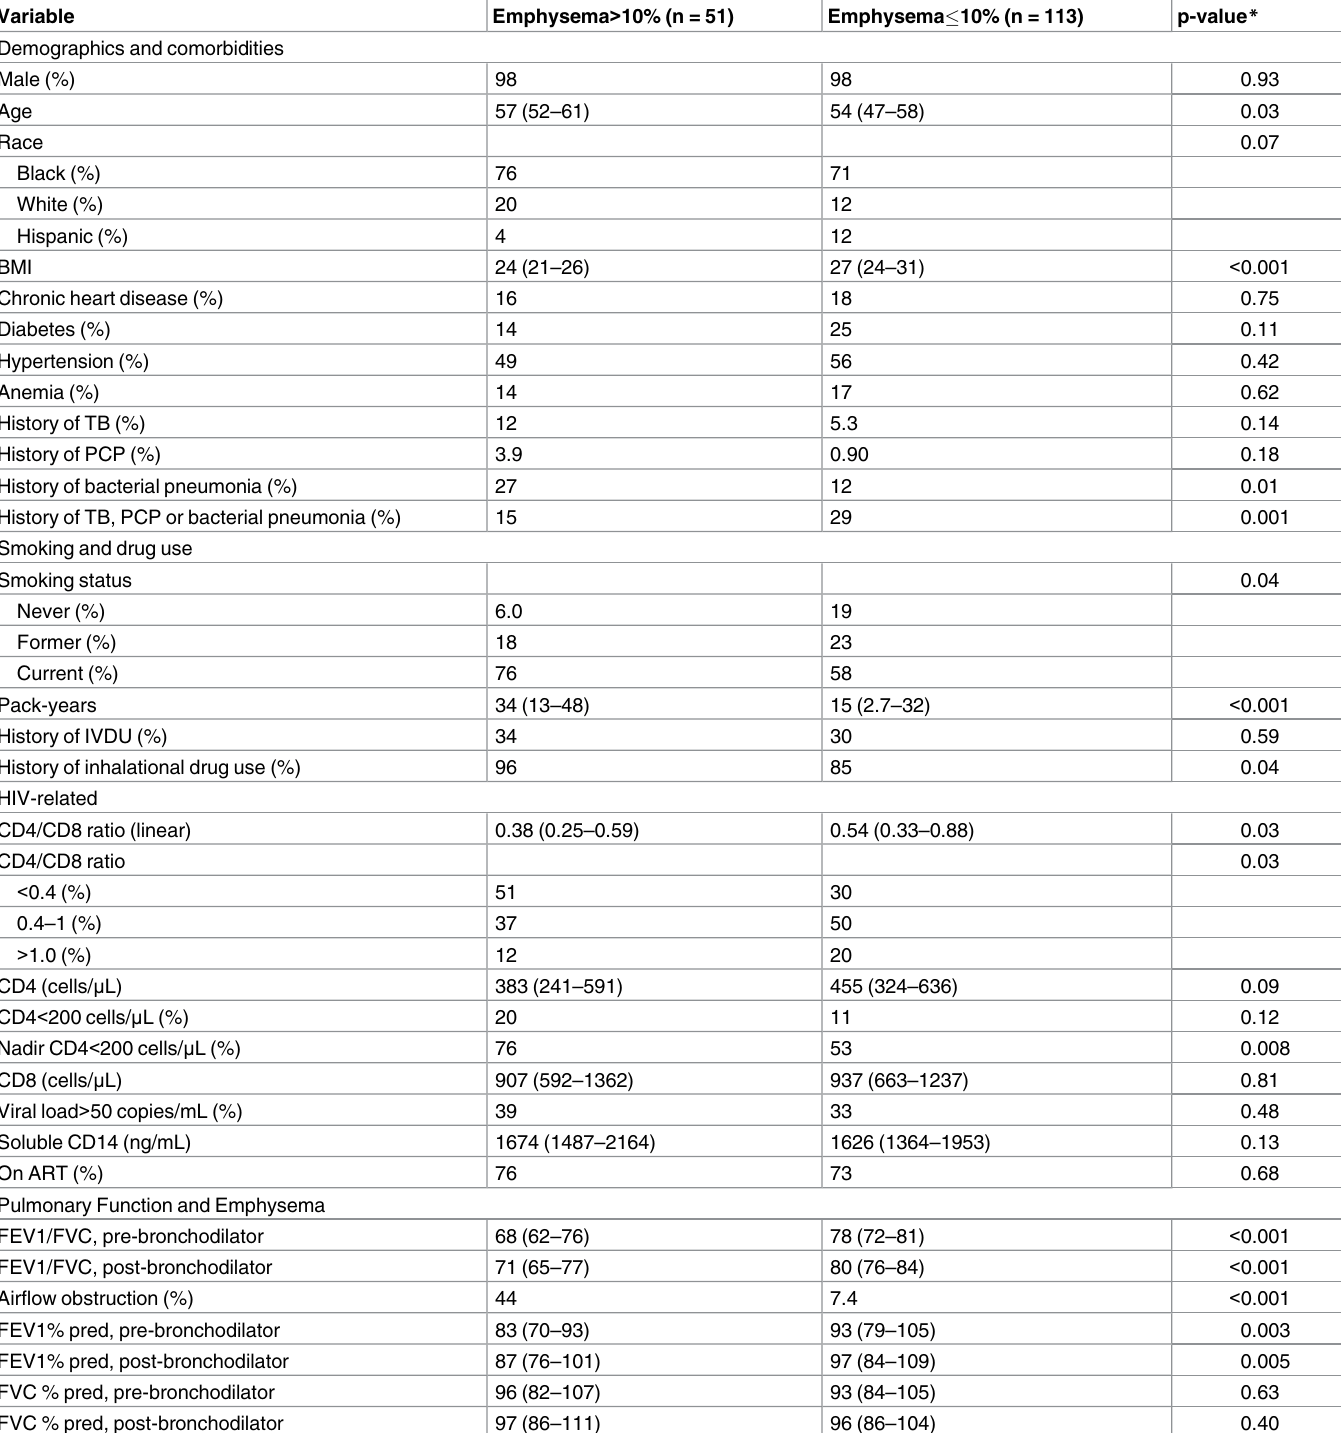
Table 2. Subject characteristics by semi-quantitative emphysema > 10%(n =